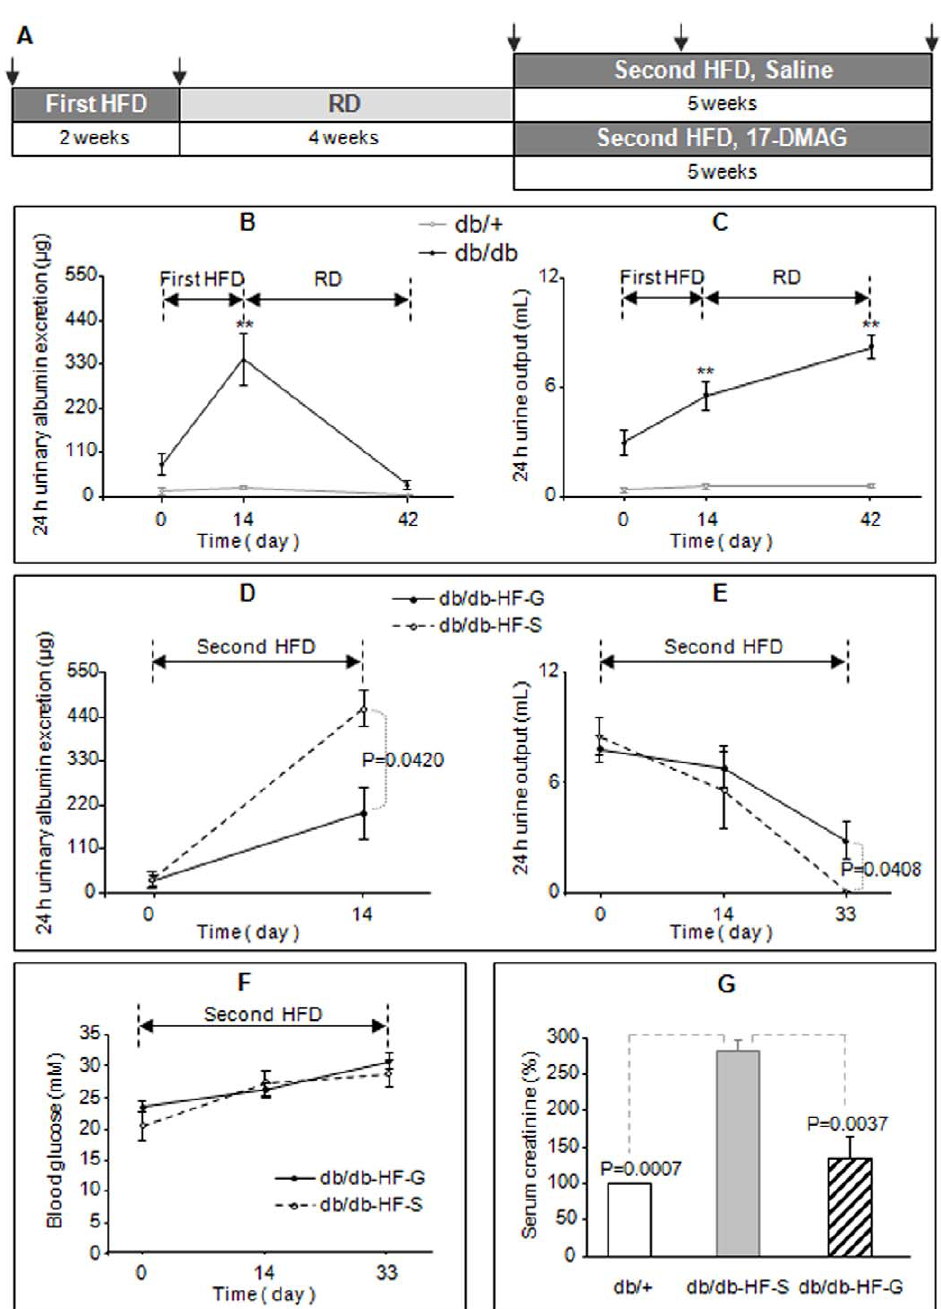
Figure 1. Effects of high fat diet (HFD) and 17-DMAG treatment on kidney function of db/db mice. ( A ) Schematic of two phases of HFD feeding and 17-DMAG treatment with the arrows indicating the scheduled kidney function assessments. During the first phase of HFD and the subsequent regular diet (RD) feeding, the 24 h urinary albumin excretion ( B ) and urine output ( C ) were measured to assess kidney functions in db/db and thenon-diabetic control( db/ + ) mice.Duringthesecondphaseof HFD feeding, theanimals wereeitherinjectedwith saline ( HF-S ) or17-DMAG( HF-G ) and the kidney functions were initially assessed by the 24 h urinary albumin excretion ( D ) and urine output ( E ), and then by serum creatinine ( G ) when anuria or oliguria occurred. Blood glucose was measured as indicated in ( F) . ** P , 0.01, compared with baseline assessed on day 0 with n=6–12 per group.